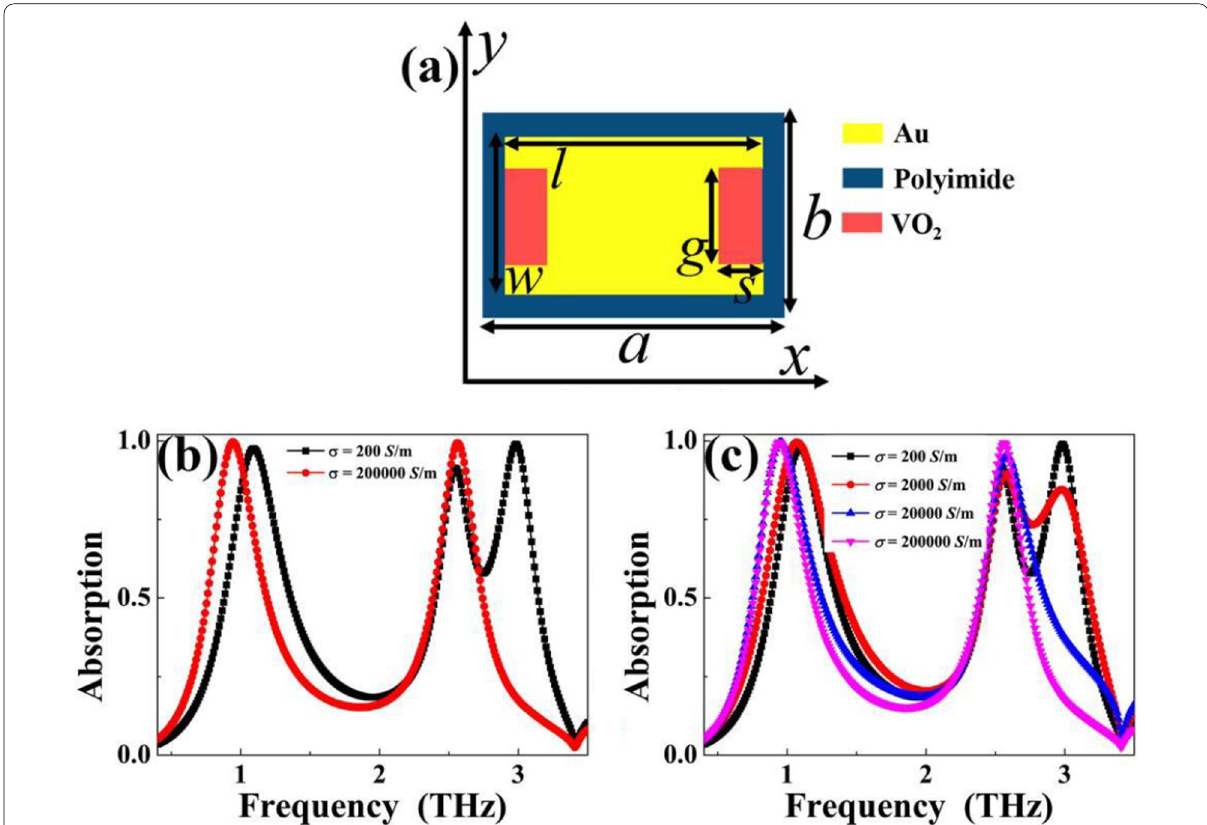
Fig. 6 a Front view of tunable metamaterial absorber (case 1) by inserting VO 2 into two notches; b Absorption curves of tunable terahertz metamaterial absorber (case 1) under conductivity values of